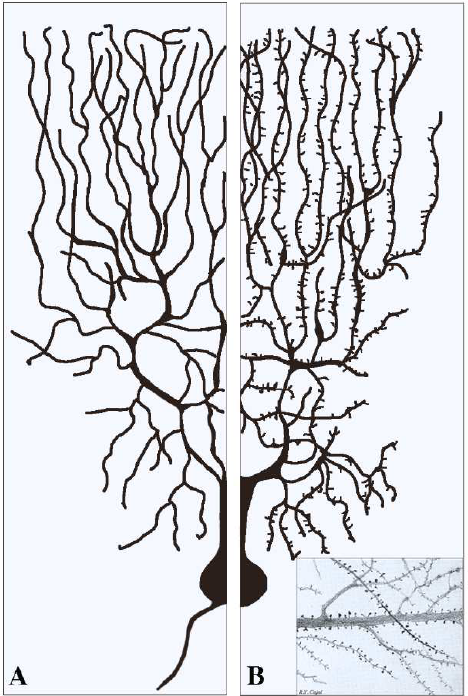
Figure 1. Examples of two dendritic arborizations with flat/intended ( A ) and spinal ( B ) post-synapses in brain neurons. In neurons the distribution of the dendritic fibers from the cell body is shown at a side opposite to that of axons (see ( A )). Pre-synapses associated with dendritic post-synapses are not shown. In ( A ) all dendritic fibers appear smooth because their post-synapses, predominant in inhibitory neurons, are flat/intended, i.e., they do not emerge or emerge only marginally from the fiber surface. Dendritic fibers shown in ( B ), analogous in general shape to those in ( A ), predominate in stimulatory neurons. Beginning at some distance from the cell body, these fibers are covered by a high density of post-synapses composed by spines. The insertion in ( B ) is a fraction of an original figure by Santiago Ramon y Cajal (1896), reported as the CAT 024 figure in the book Ciencia y Arte by the Instituto Cajal, Madrid, 2004.